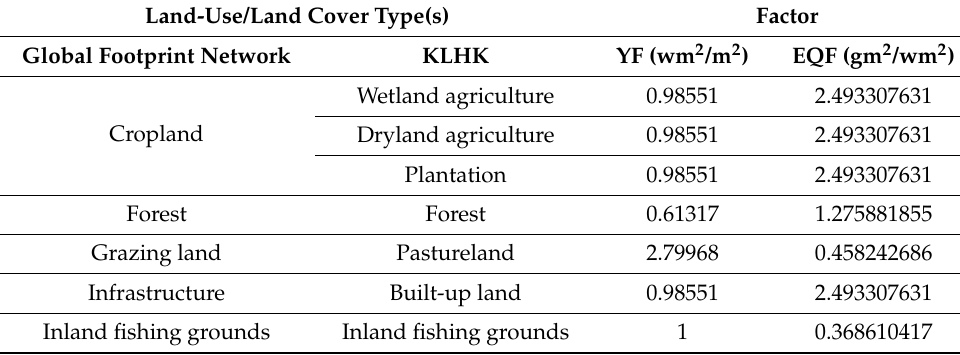
Table 3. The yield factor (YF) and equivalent area factor (EQF) values for the Indonesian region (Global Footprint Network,